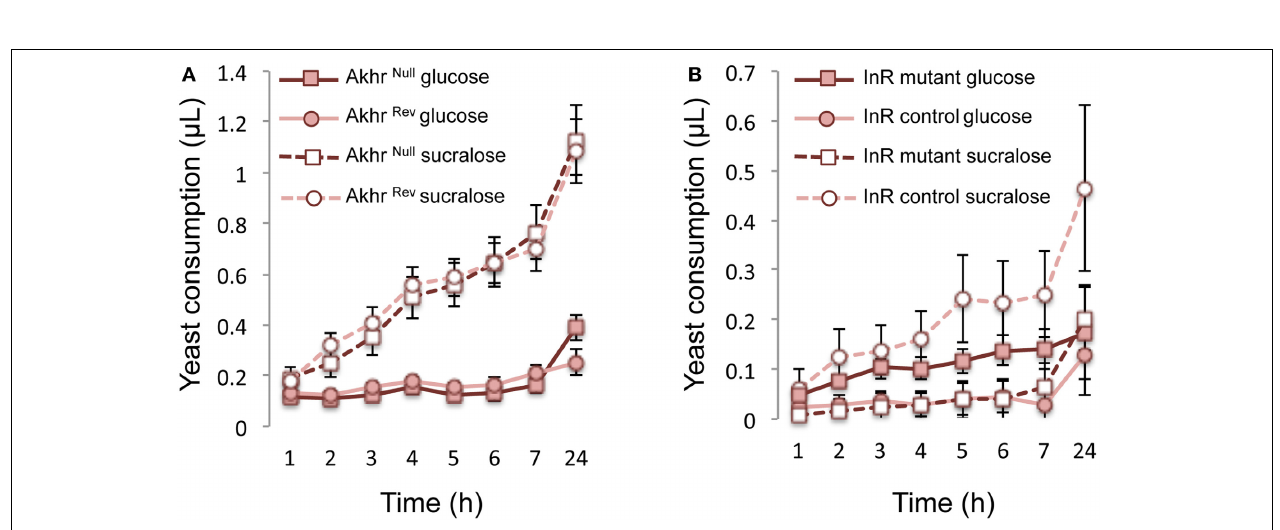
FIGURE 3 | Hormonal regulation of yeast feeding behavior. (A) Role of AKH and (B) insulin pathway on yeast consumption, in response to dietary sugars. All data are mean ±